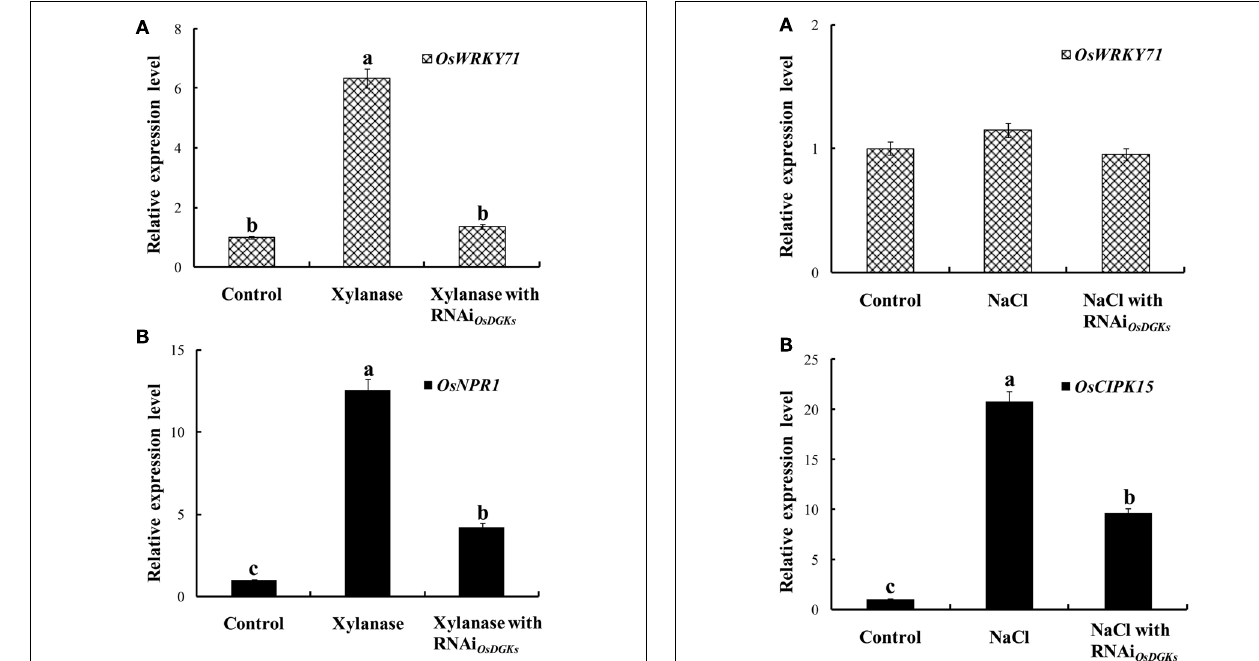
FIGURE 8 | Effects of silencing of OsDGKs on transcription of OsWRKY71 and OsCIPK15 induced by NaCl in rice cells. Following transient RNAi using two in vitro -synthesized dsRNAs against conserved regions of OsDGK ( 1 , 2 , 3 , 7 ) and OsDGK ( 4 , 5 , 8 ) for 24h, the transfected protoplasts were treated with 50mM NaCl for 6h.The protoplasts were collected for real-time PCR analysis to detect transcripts of OsWRKY71 (A) and OsCIPK15 (B) .Values followed by different letters differ significantly ( P <